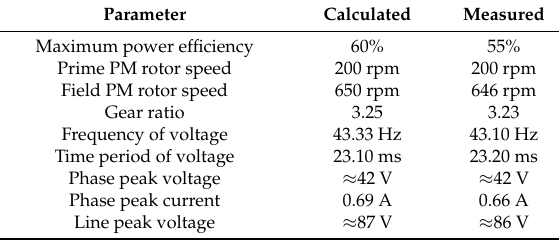
Table 7. Comparison of performance characteristics for prototype magnetic geared